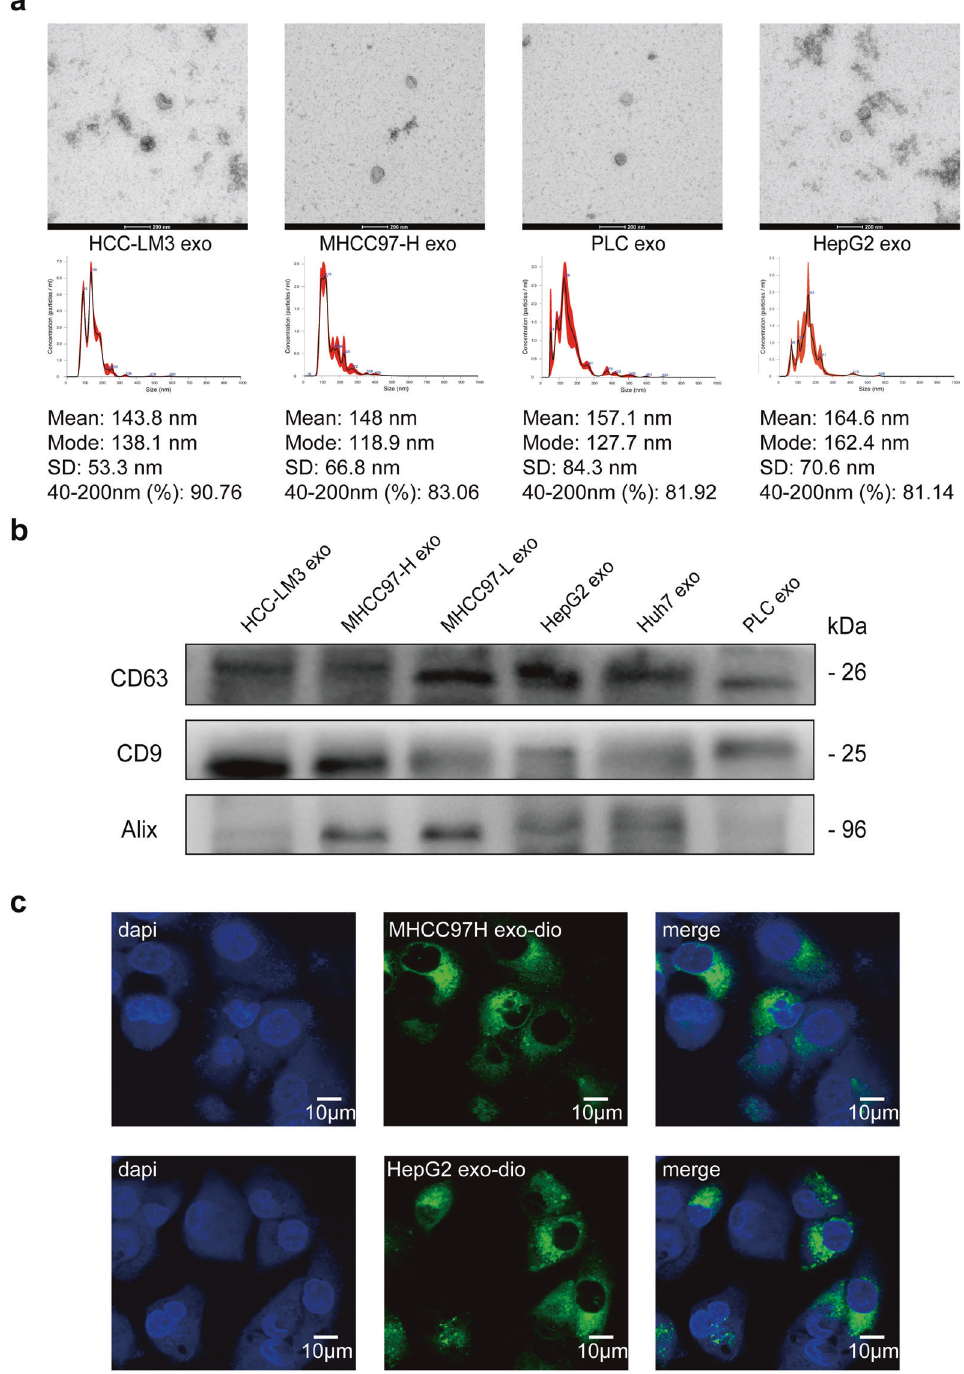
Fig. 1 Isolation and identi fi cation of exosomes released and up-taken by HCC cells. a Transmission electron microscopy of isolated exosomes from HCC cells (HCC-LM3, MHCC97-H, PLC, and HepG2, Scale bar: 200 nm). The concentration and size distribution were determined by nanoparticle tracking analysis (NTA). b Western blot of exosomal marker CD63, CD9, and Alix in exosomes isolated from HCC cell lines (HCC- LM3, MHCC97-H, MHCC-97-L, HepG2, Huh7, and PLC). c Laser scanning confocal microscope images of DIO treated exosomes (MHCC97H exo and HepG2 exo) up-taken by low metastatic HCC cells